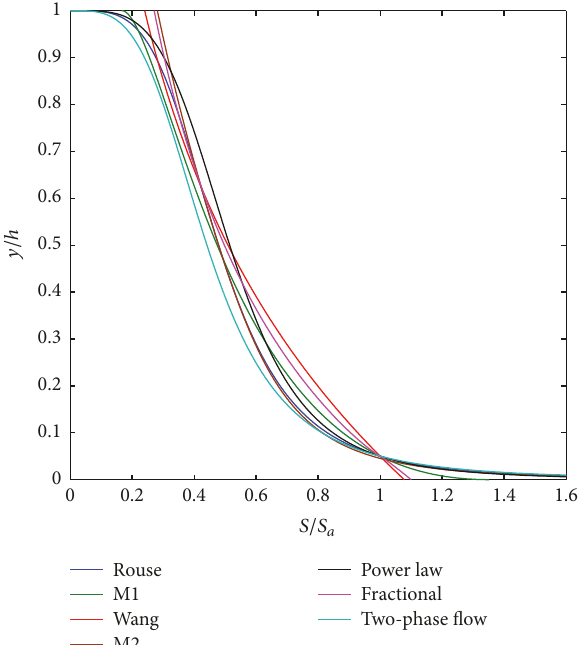
Figure 1: Numerical results of different models in describing the vertical distribution of sediment suspension. Von Karman constant 𝜅 = 0.4 , shear velocity 𝑢 ∗ = 0.10 , sediment settling velocity 𝜔 = 0.01 , water depth ℎ = 1.0 , 𝑎 = 0.05ℎ , and 𝛼 = 0.9 in the fADE model. For description simplicity, units are not used for parameters in this figure.